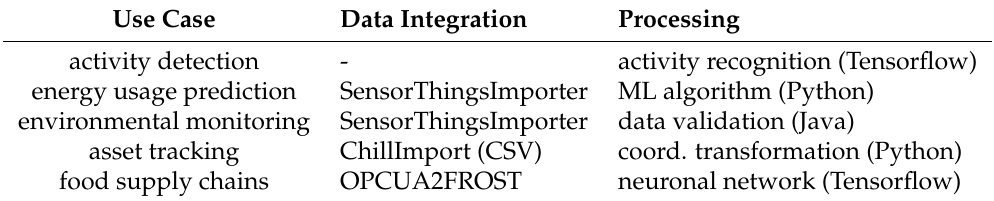
Table 1. Summary of the realized use